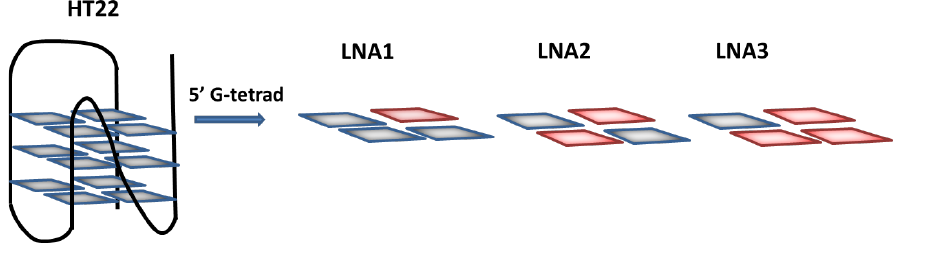
Figure 5: Scheme of LNA point –modifications of 5’ G-quartet of telomeric G-quadruplex. Blue squares represents DNA guanidine nucleotides and red squares represents LNA guanidine nucleotides.